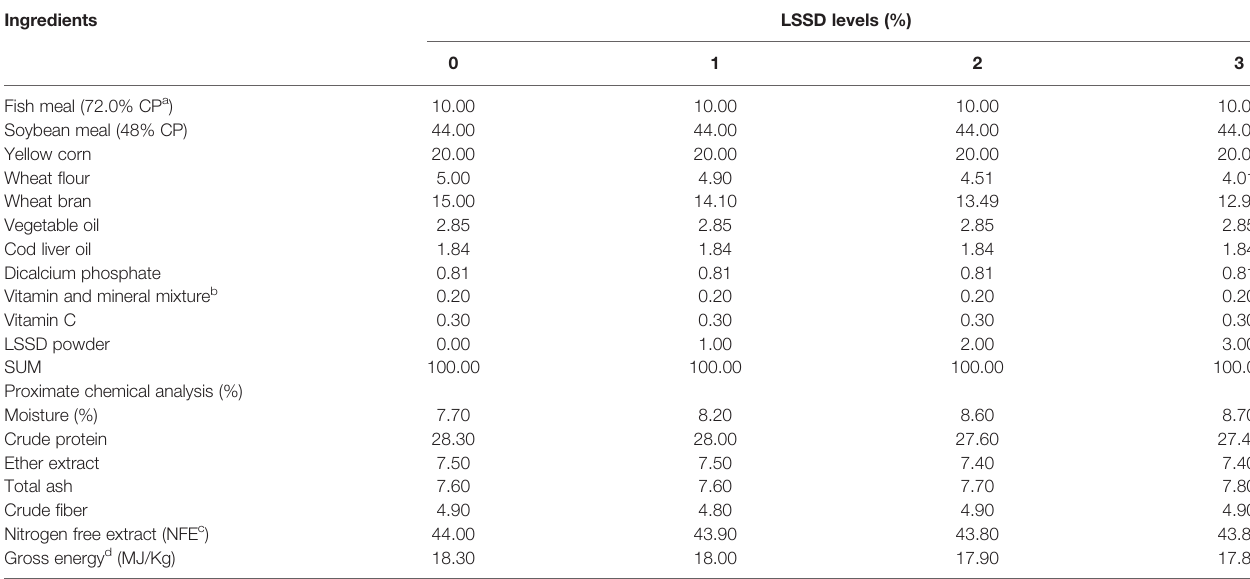
TABLE 1 | Ingredients and chemical composition (%) of the diet.